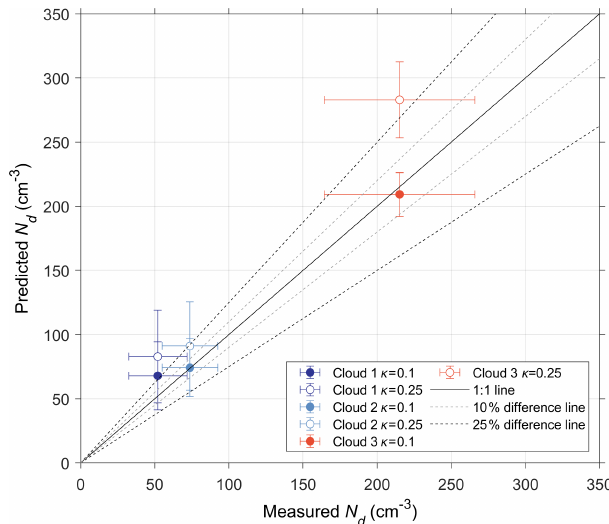
Figure 6. Comparison between average predicted N d (cm − 3 ) with the droplet activation parameterization and observed N d (cm − 3 ) during the three cloud events on 7 March (blue and cyan circles) and 8 March (orange circles) 2019. For all three cloud events, droplet closure is performed assuming a κ parameter of 0.1 (filled circles) and 0.25 (empty circles). The error bars represent the standard de- viation of N d during each cloud